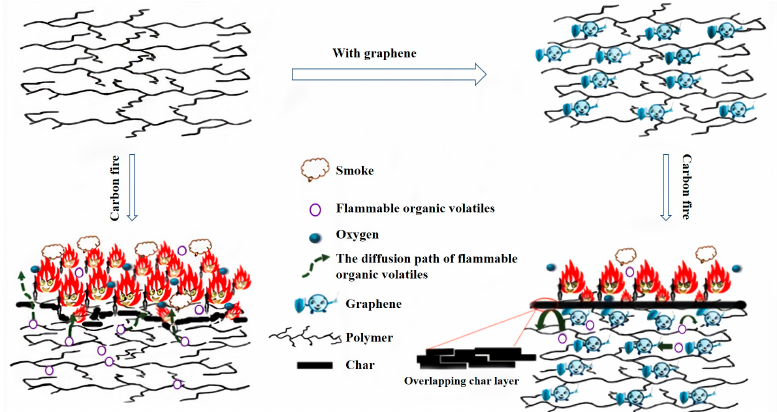
Figure 8. Schematic diagram showing the flame retarding mechanism of graphene-based flame retardant under ideal conditionReprinted with permission from Ref. [107]. Copyright 2016, Springer Nature.